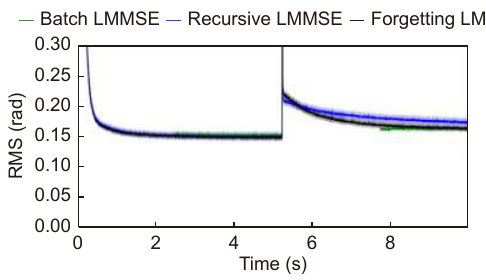
Fig. 14 | Wind jumps of 7 m/s showing the convergence of the recursive LMMSE (blue) and the forgetting LMMSE (black), as well as the resetting of the batch LMMSE (green) for a re- gressor with a 3-by-3 spatial grid and five previous measure- ments for each phase point. Figure reproduced from ref. 87 , Optical Society of America.